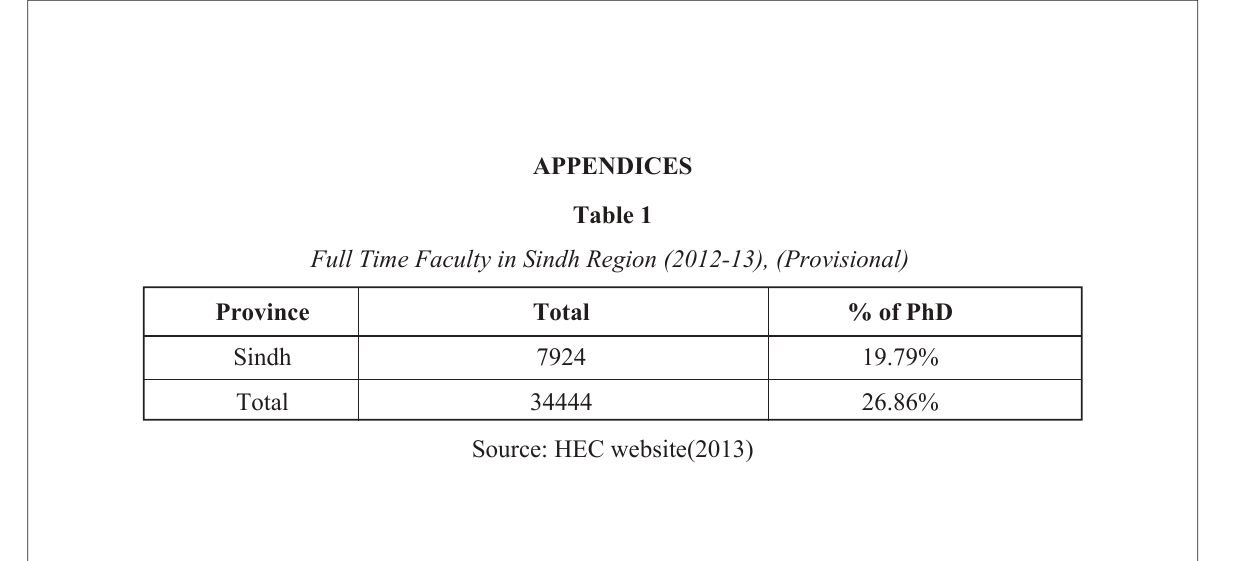
Structural Relationship Model with standardized